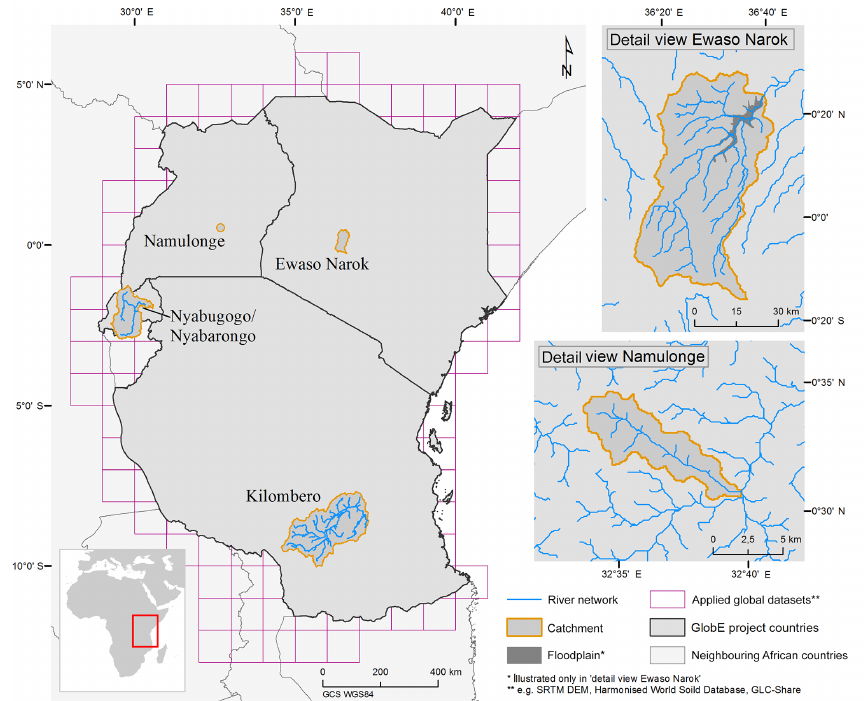
Figure 1. Nested experimental test site/regional wetland – catchment data base approach for East Africa comprising the countries Kenya, Uganda, Rwanda, and Tanzania. (http://gadm.org/, 2015 and Jet Proulsion Laboratory, 2015,